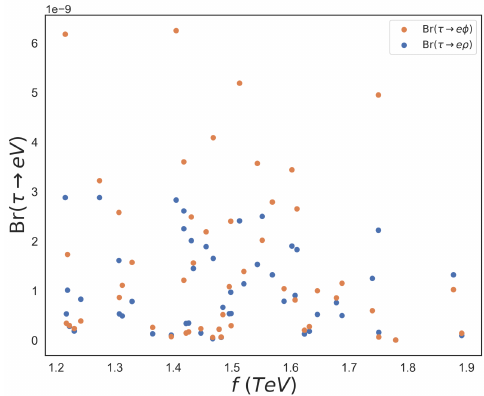
Figure 8 . Scatter plot f vs. Br( τ → eP ) without Majorana neutrinos.